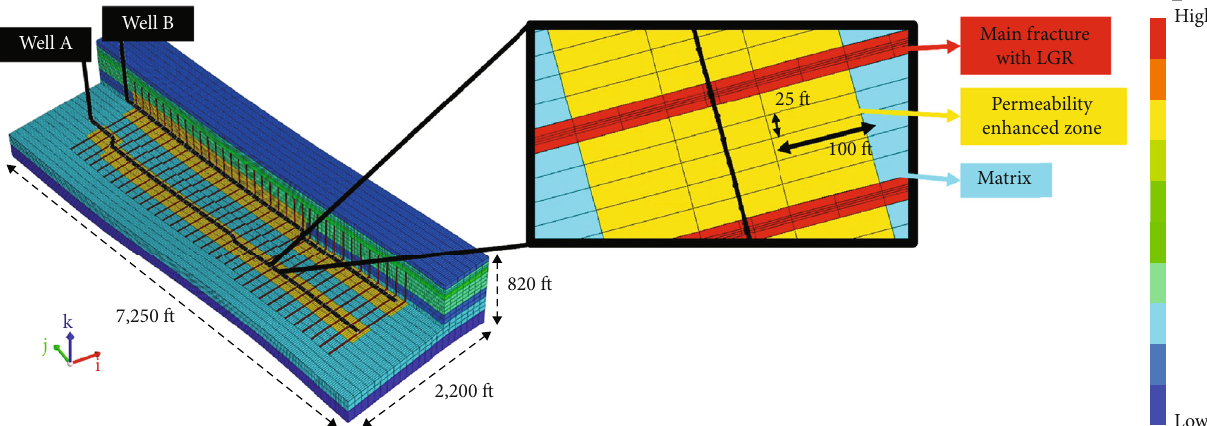
Figure 3: Reservoir simulation model for history matching.